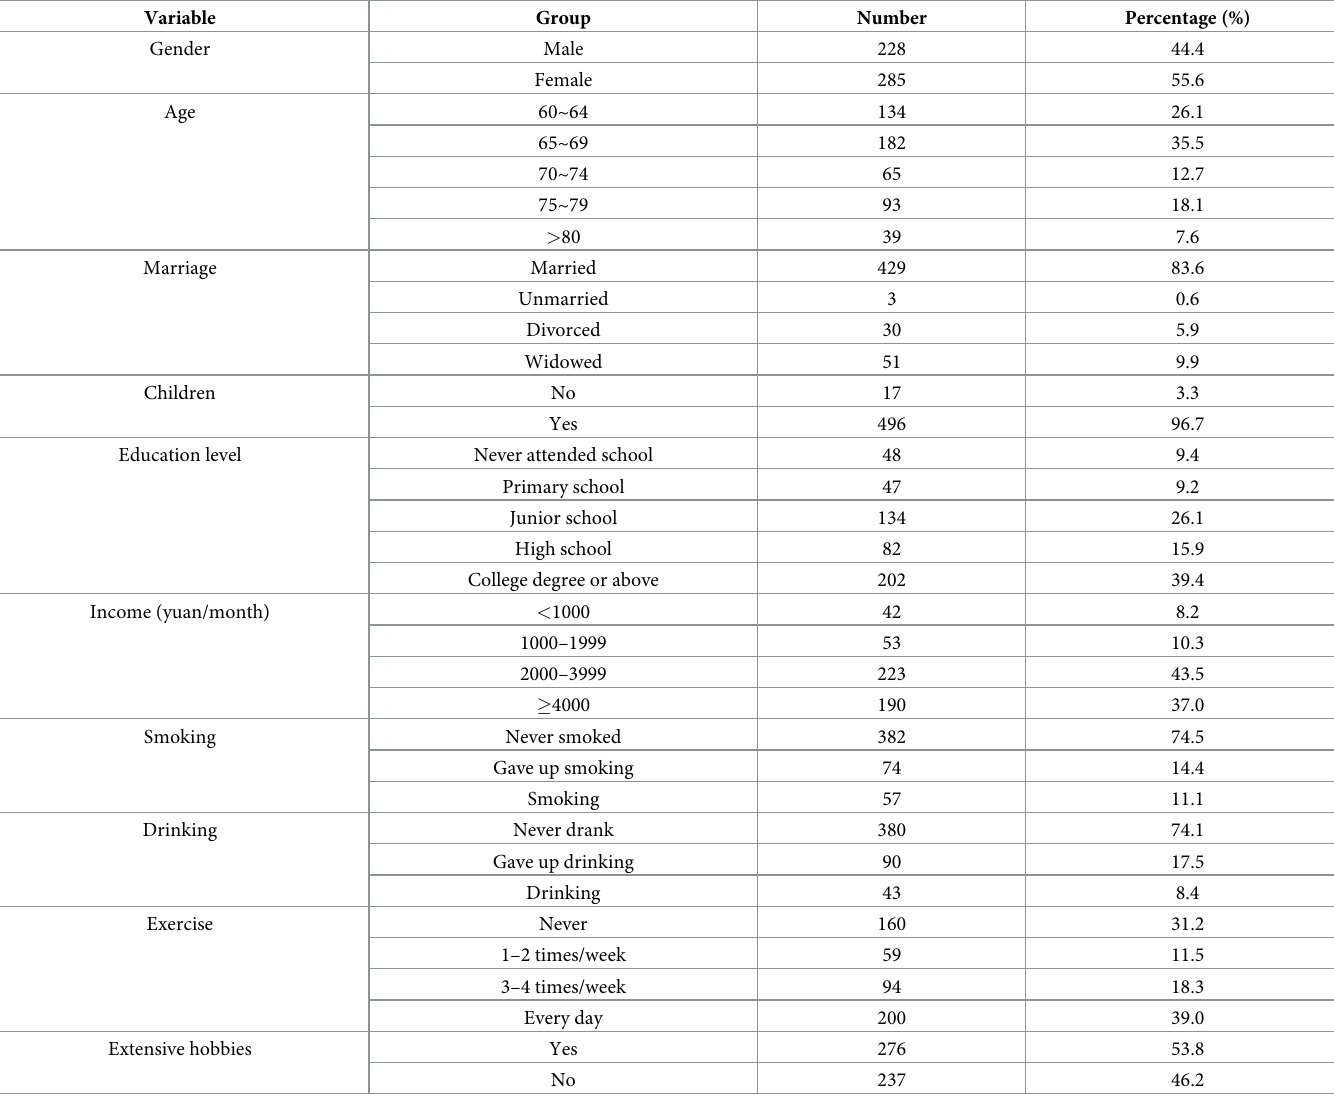
Table 1. Characteristics of the study sample (n =